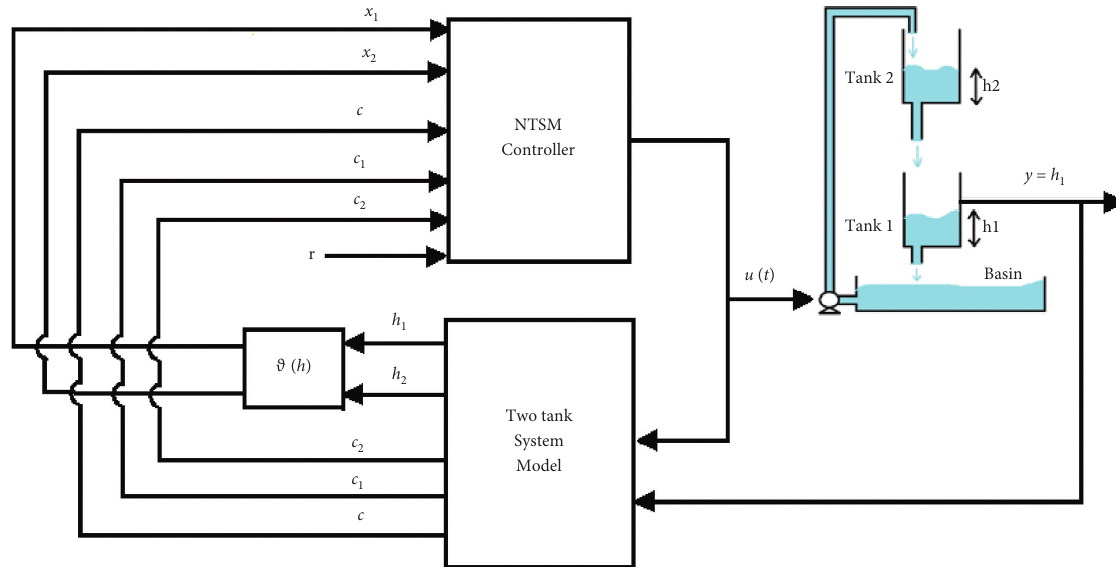
Figure 2: Structure of the NTSM